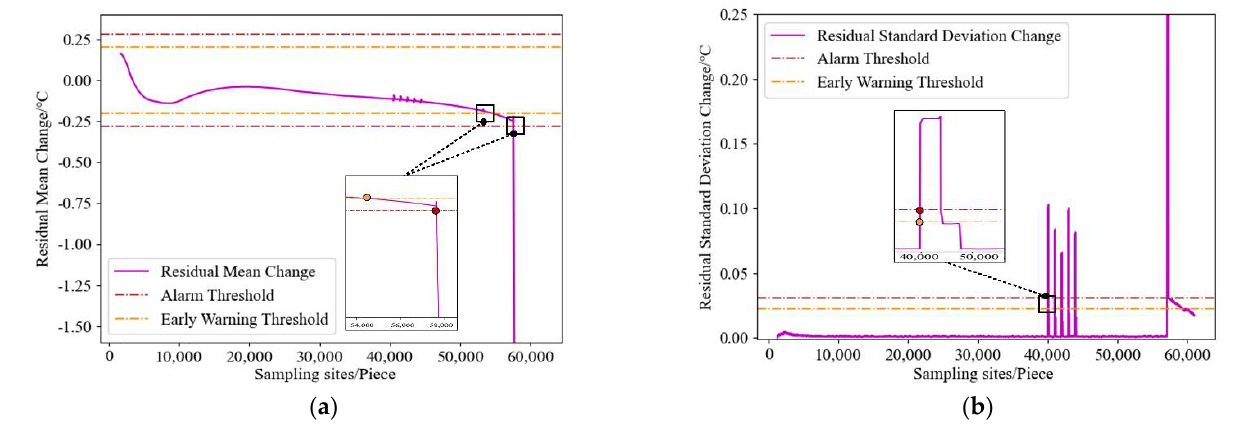
Figure 10. Safe pre-warning results for training set 1 of the simulation model. ( a ) Residual mean change. ( b ) Residual standard deviation change. change. ( b ) Residual standard deviation